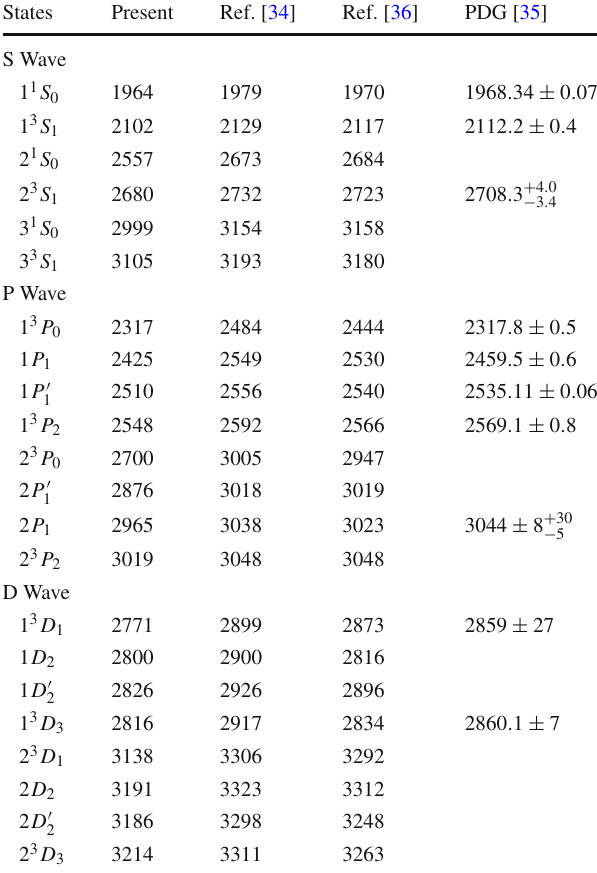
Table 2 Spectrum of the charmed-strange mesons in unit of MeV. For comparison, we also list the theoretical estimations in Refs. [34,36] and experimental measurements [35]